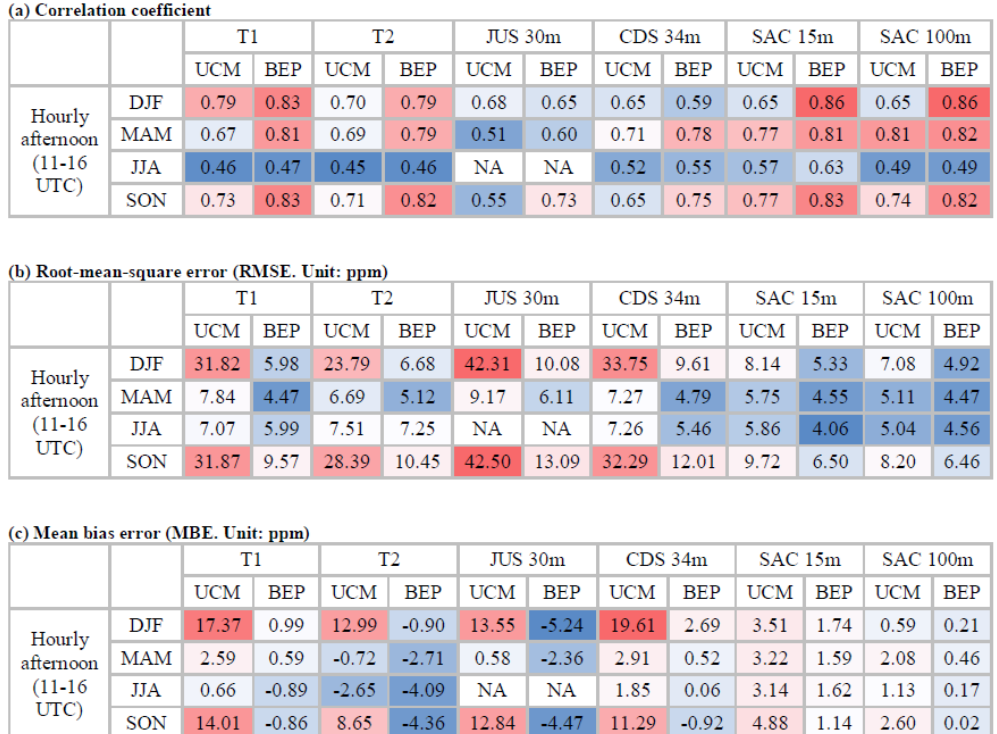
Table 3. Seasonal statistics for observed and modeled hourly afternoon CO 2 concentrations for two urban canopy schemes (UCM, BEP) from December 2015 to November 2016. DJF denotes December–January–February, MAM denotes March–April–May, JJA denotes June– July–August, and SON denotes September–October–November. The color highlights the value in the cell, with the minimum in blue, the median in white, and the maximum in red. All other cells are colored